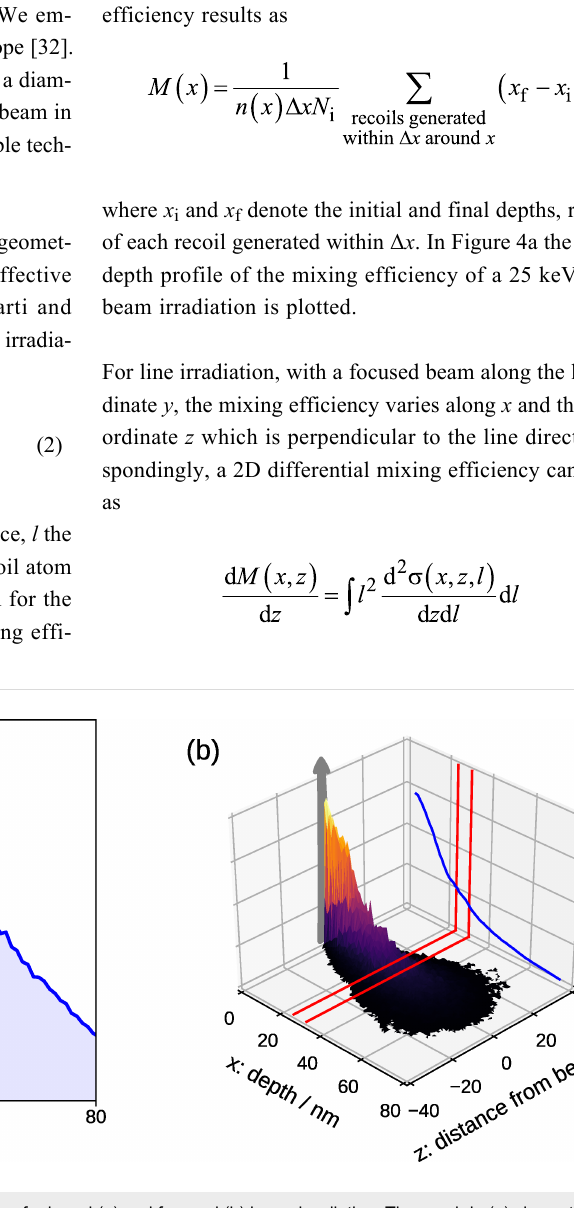
Figure 4: Static TRIDYN-based simulation of the mixing efficiency for broad (a) and focused (b) beam irradiation. The graph in (a) shows the mixing efficiency of a 25 keV Ne + broad beam on a layer stack of 25 nm Si and 6.5 nm SiO 2 on a Si substrate. The position of the oxide is indicated by red lines. A similar calculation for a 25 keV focused Ne + ion beam is presented in (b). The mixing efficiency along the beam direction at the position of the beam is plotted in the x , y plane. The gray arrow indicates the lateral coordinate y along which the beam is scanned. The full width at half maximum of the mixed volume at the depth of the buried oxide is approximately 10 nm. This is five times larger than the beam diameter on the surface of 2